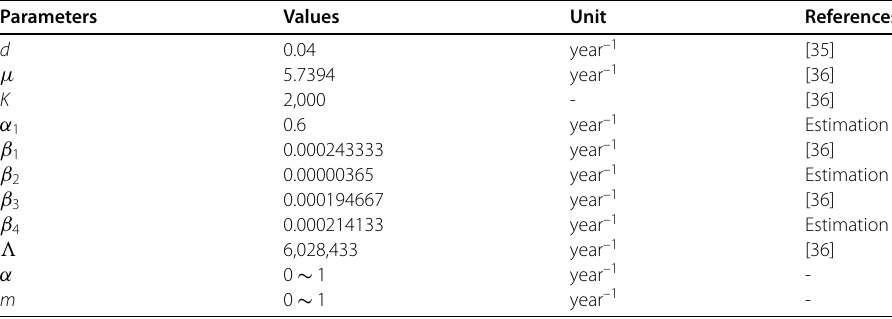
Table 1 Parameter values used for numerical simulations of the HLB model